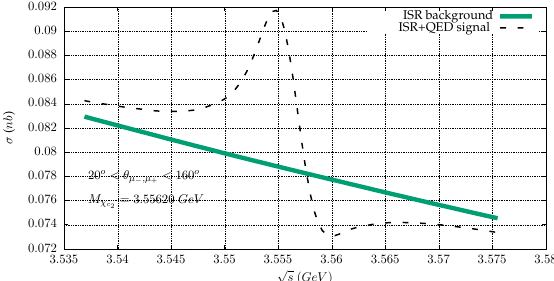
Figure 6. The cross section e + e −